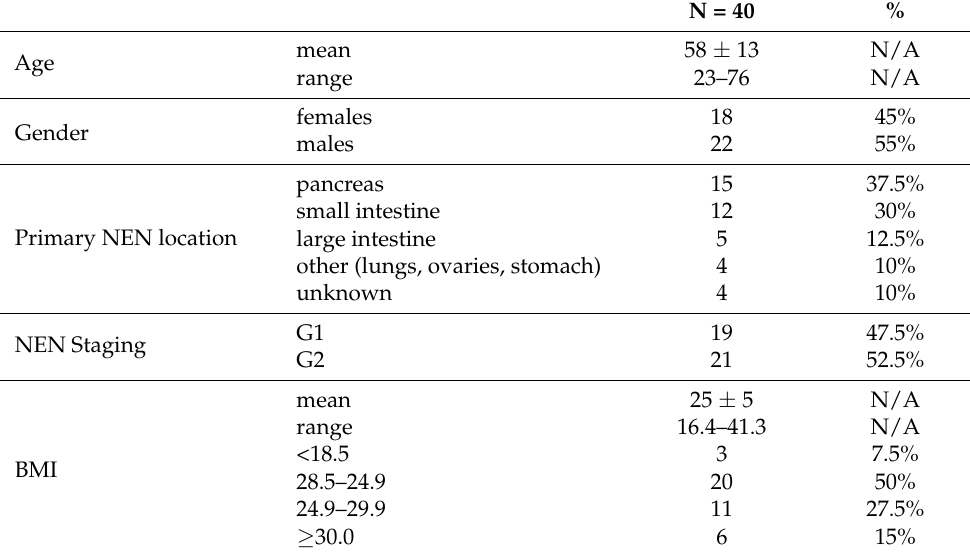
Table 1. Characteristics of the study group.